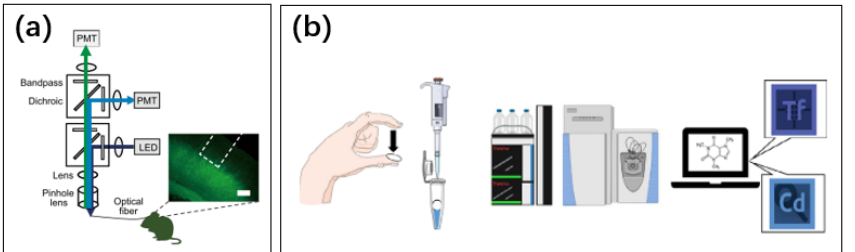
Figure 19. ( a ) Measurement of ATP concentration in mouse brain using optical methods [250]. Re-